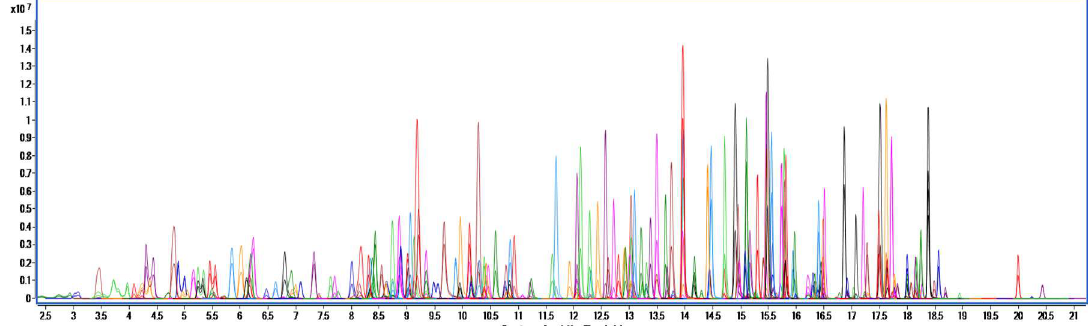
Figure 1. Typical chromatograms of 244 chemical contaminants in egg samples at the spiked concentration of 50 μg kg −1 .